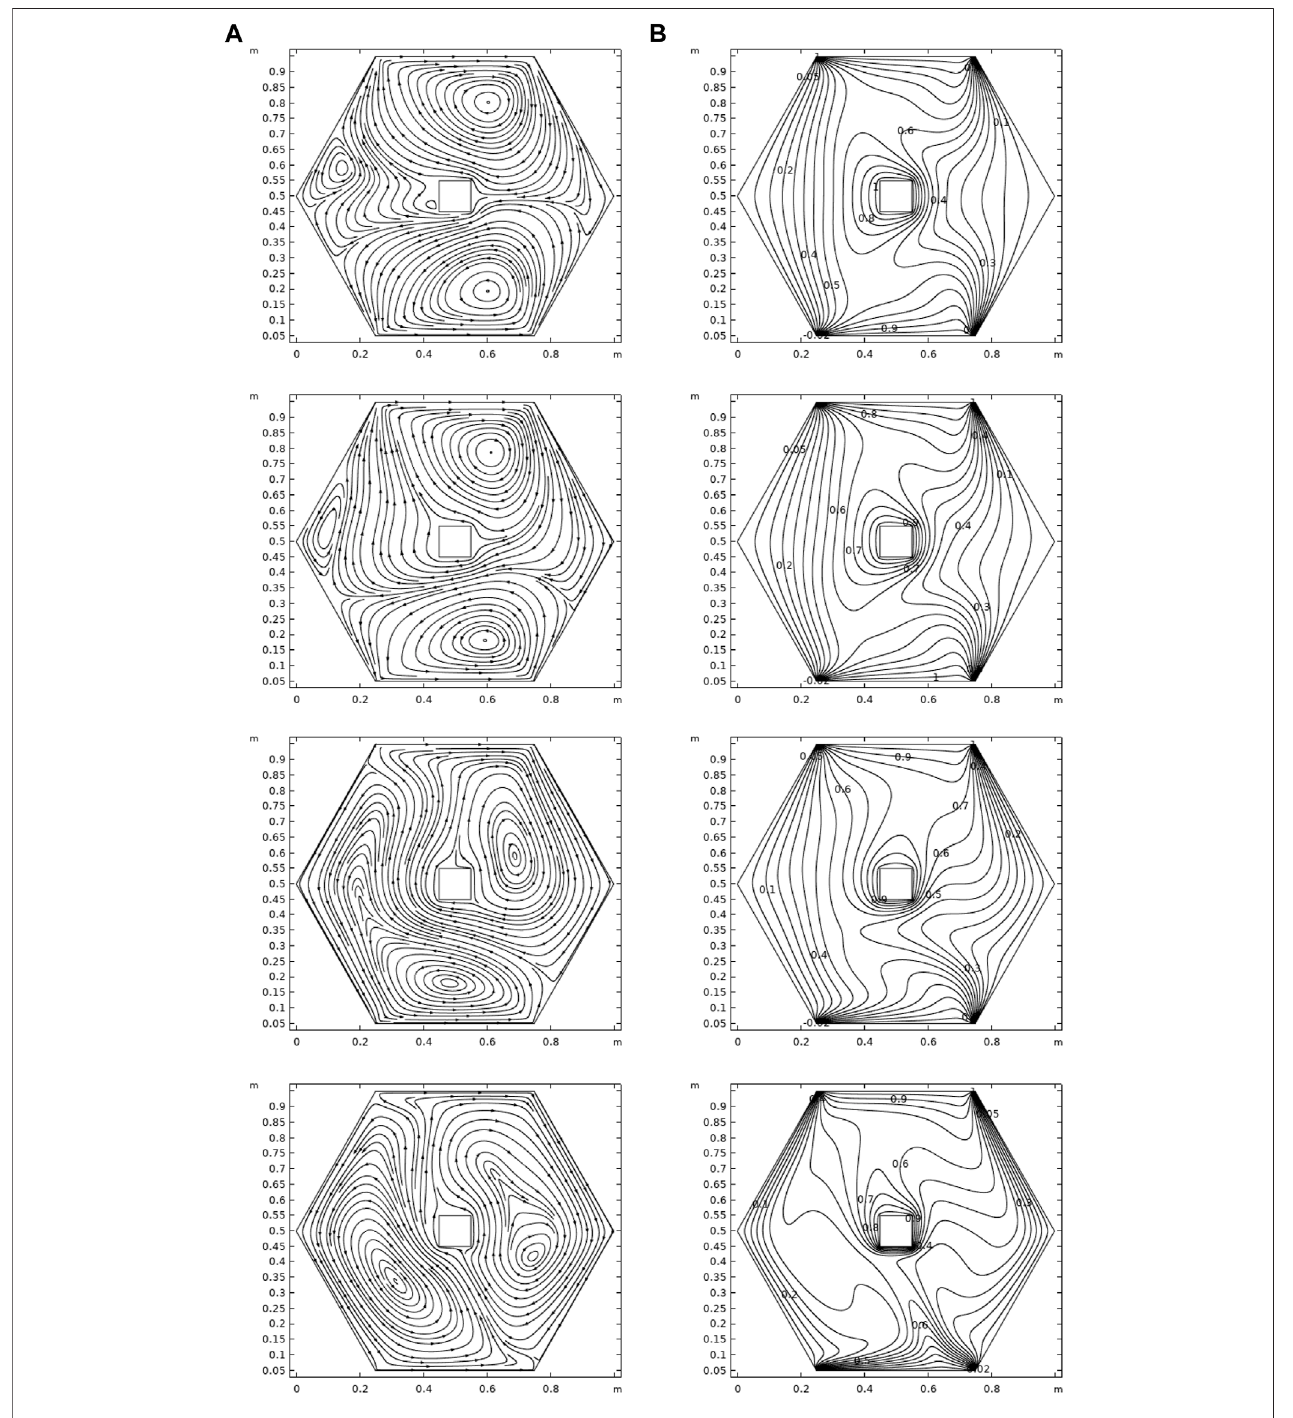
FIGURE 5 | In fl uence on streamline (A) and isotherm (B) with different Gr with n (cid:2) 0 . 5 , Pr (cid:2) 1, and Re (cid:2) 200 .